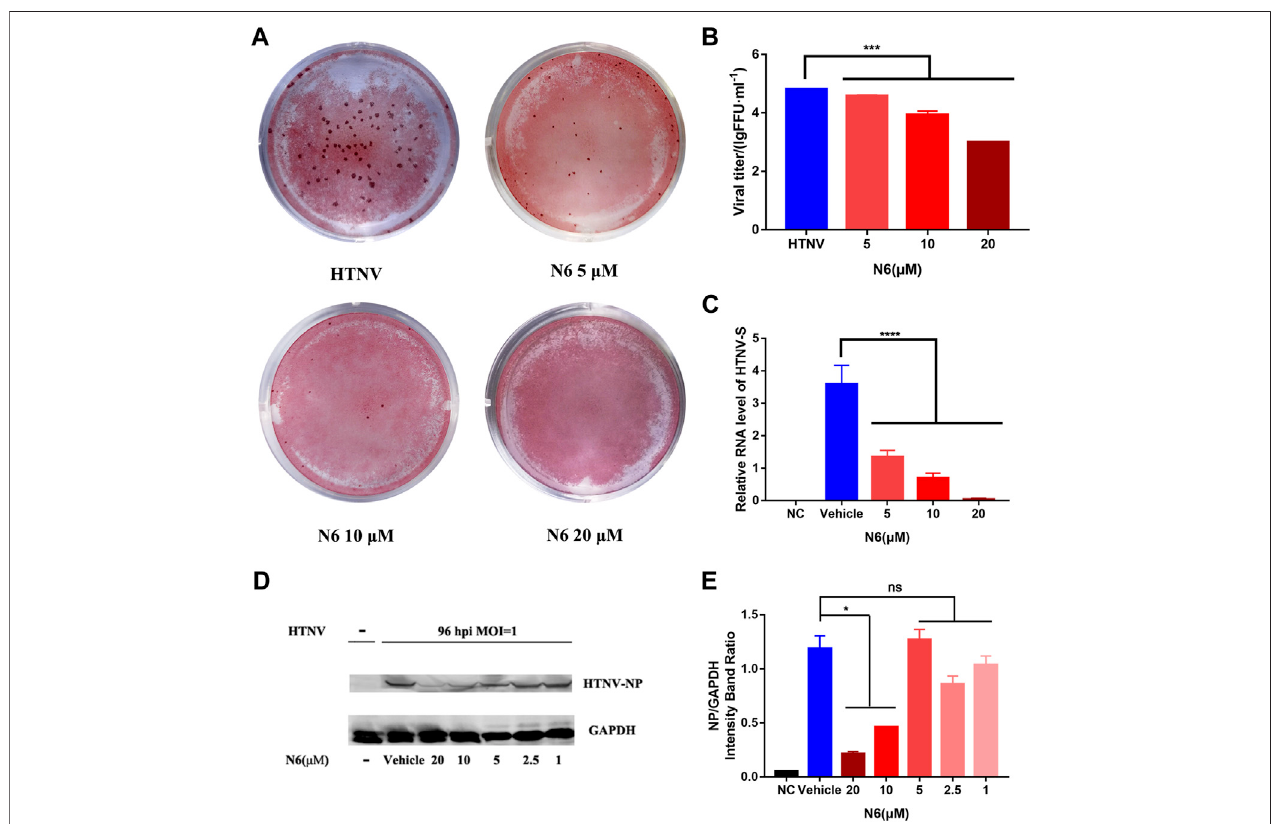
FIGURE 3 | N6 inhibited HTNV replication in A549 cell post infection (A) The representative imaging for the focus-forming unit of HTNV with N6 treatment at 5, 10, and 20 μ M (B) The viral titer of HTNV was analyzed in the untreated HTNV group (HTNV) and N6 treatment groups (C) The expression of HTNV-S RNA in the negative control (NC) group, vehicle-treated group, and N6-treated groups (D) The representative Western blot staining for HTNV NP protein in the negative control (NC) group, vehicle-treated group, and N6-treated groups (E) The analyzed result of the expression of HTNV-NP in A549 cell post infection. Results of the statistical analyses are depicted as follows: Student ’ s t test or one-way ANOVA; * p < 0.05, *** p < 0.001, **** p < 0.0001 vs HTNV, n (cid:2)